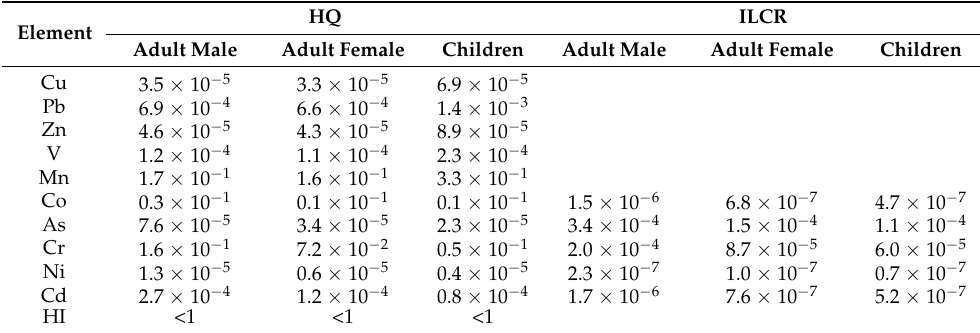
Table 2. Health risk assessment table for 10 heavy metal elements in PM 2.5 .